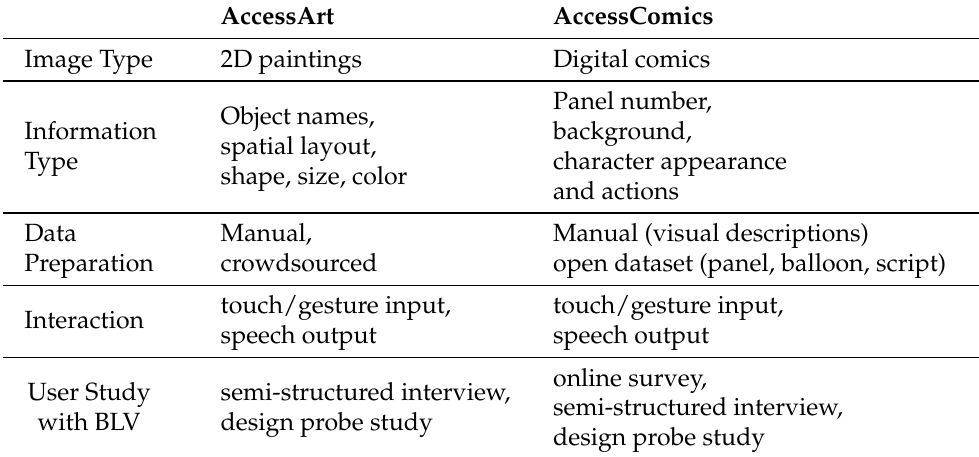
Table 7. A summary of AccessArt and AccessComics following identifying factors used in our systematic